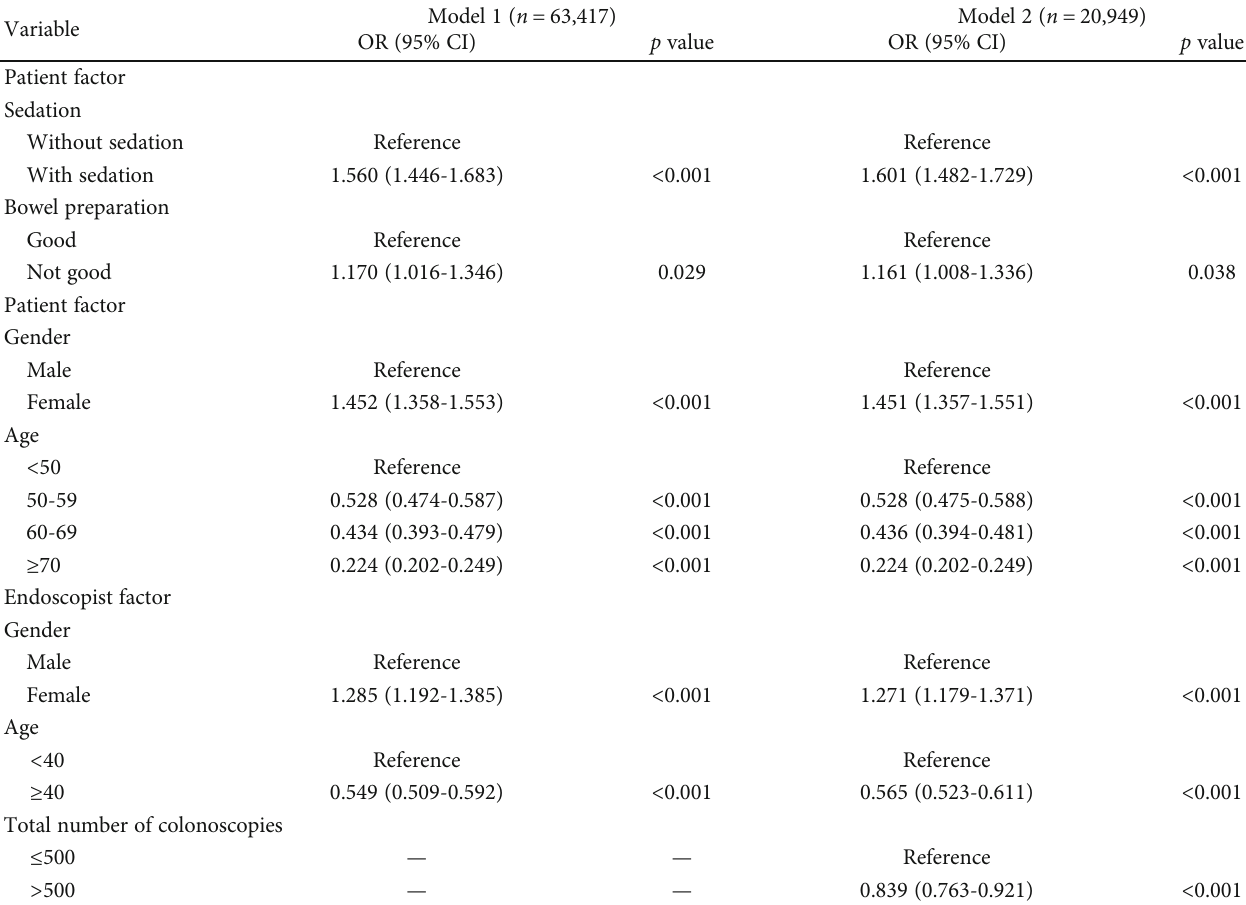
Table 4: Logistic regression analysis of risk factors for cecal intubation